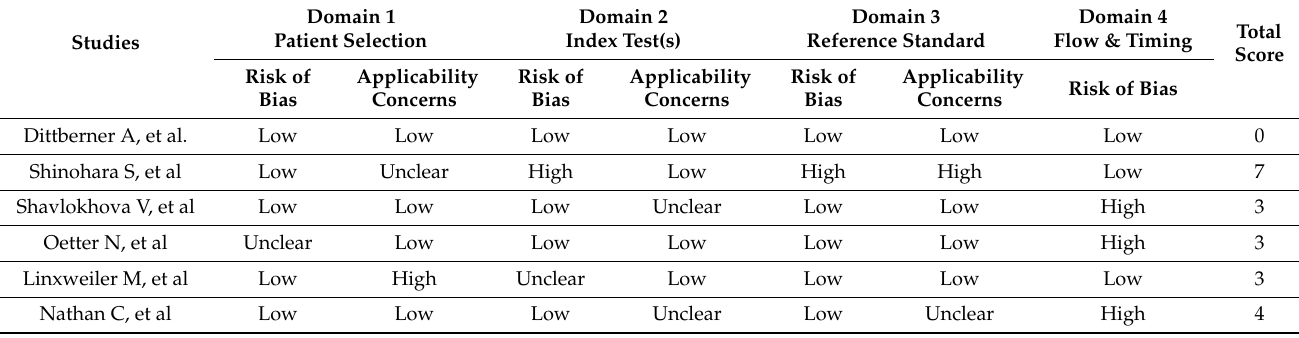
Table 3. Methodological assessments using QUADAS-2 tool. Each domain is assessed for risk of bias and first three for their applicability